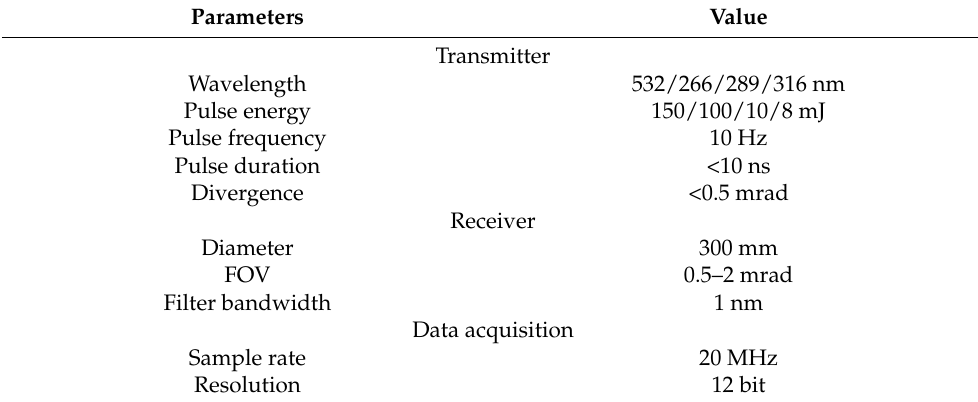
Table 1. Key parameters of the Lidar